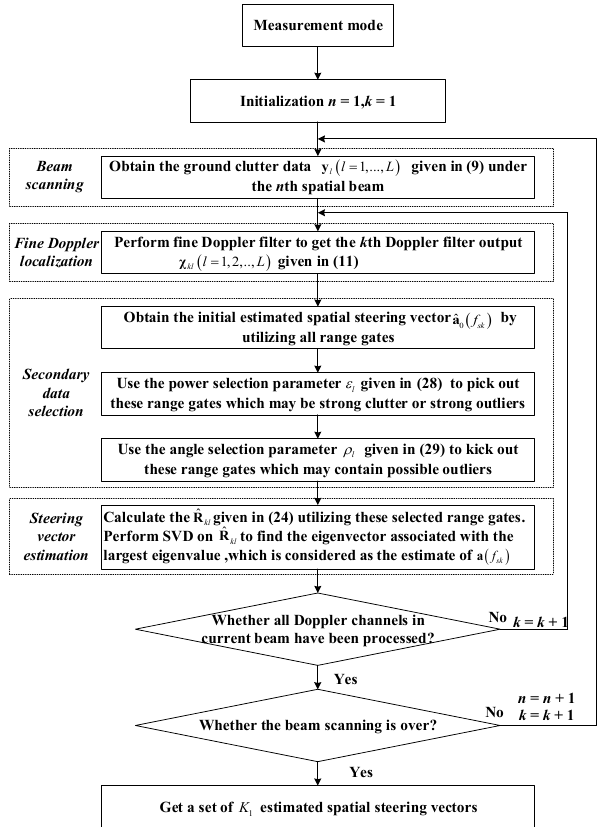
Figure 3. The flow chart of the first stage of the proposed two-stage SR-STAP